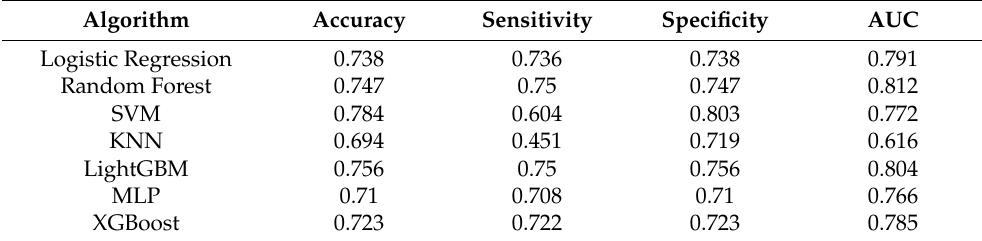
Figure 3. ROC of mortality in patients with COPD. Table 3. Testing results of the predictive models for acute respiratory failure.